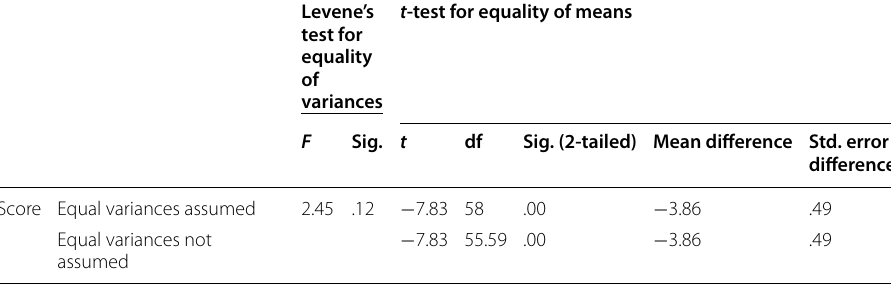
Table 4 Inferential statistics (accuracy post‑test of both groups)